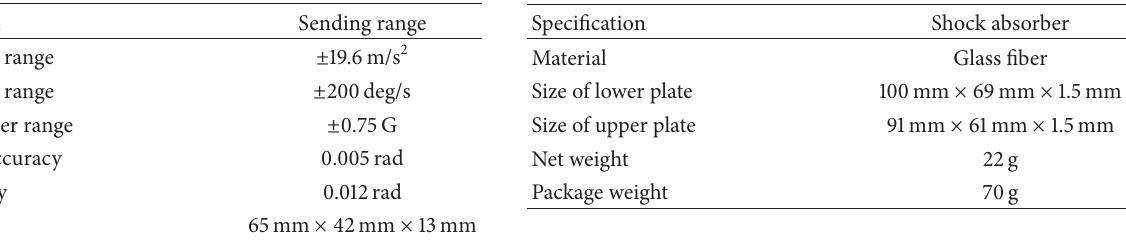
Table 2: Specifications of the flight control system components.